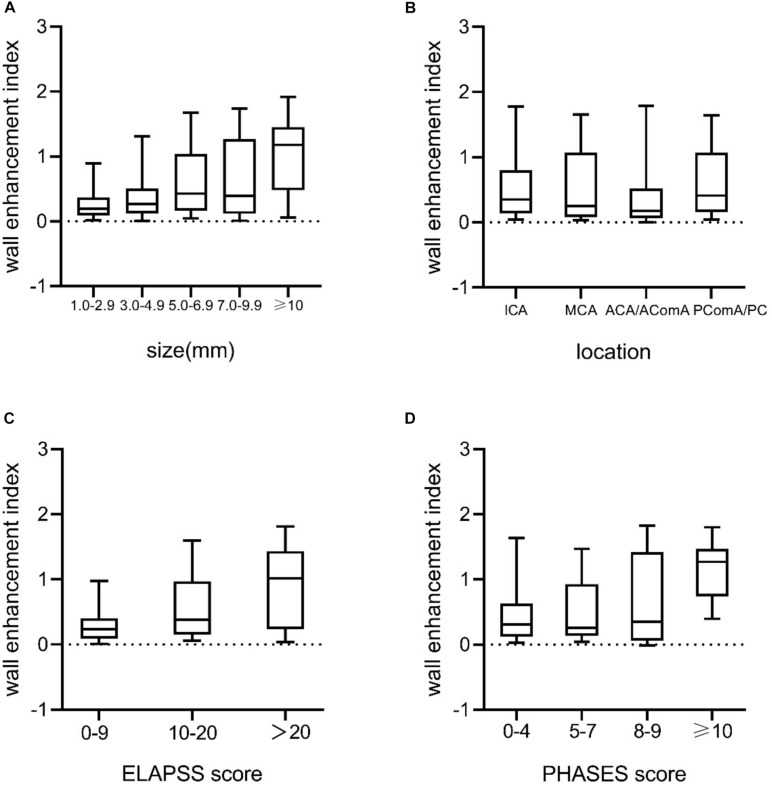
Box-and-whisker plots of medians (lines within boxes), interquartile ranges (upper and lower ends of boxes), and 5th and 95th percentiles (bottom and top lines) for WEI according to (A) aneurysm size (mm), (B) location, (C) ELAPSS score, and (D) PHASES score. WEI, wall enhancement index; ICA, internal carotid artery; MCA, middle cerebral artery; ACA, anterior cerebral artery; AComA, anterior communicating artery; PComA, posterior communicating artery; PC, posterior circulation.